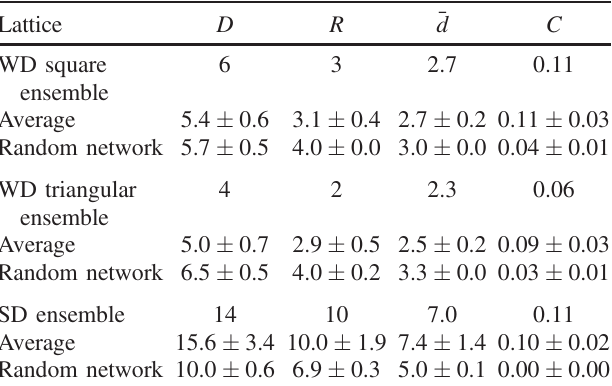
TABLE I. Topological parameters of the kinetic networks of stationary points. Results are given for the weakly disordered (WD) and strongly disordered (SD) nanostructures illustrated in Fig. 1, for the average of over more than 200 different arrange- ments of the magnetic NPs, and for a random network having the same number of nodes and edges: diameter D , radius R , average ¯ d path distance between all nodes , and transitivity C . Distances are measured in numbers of elementary transitions. See also Figs. 2 – 4 and Sec. II